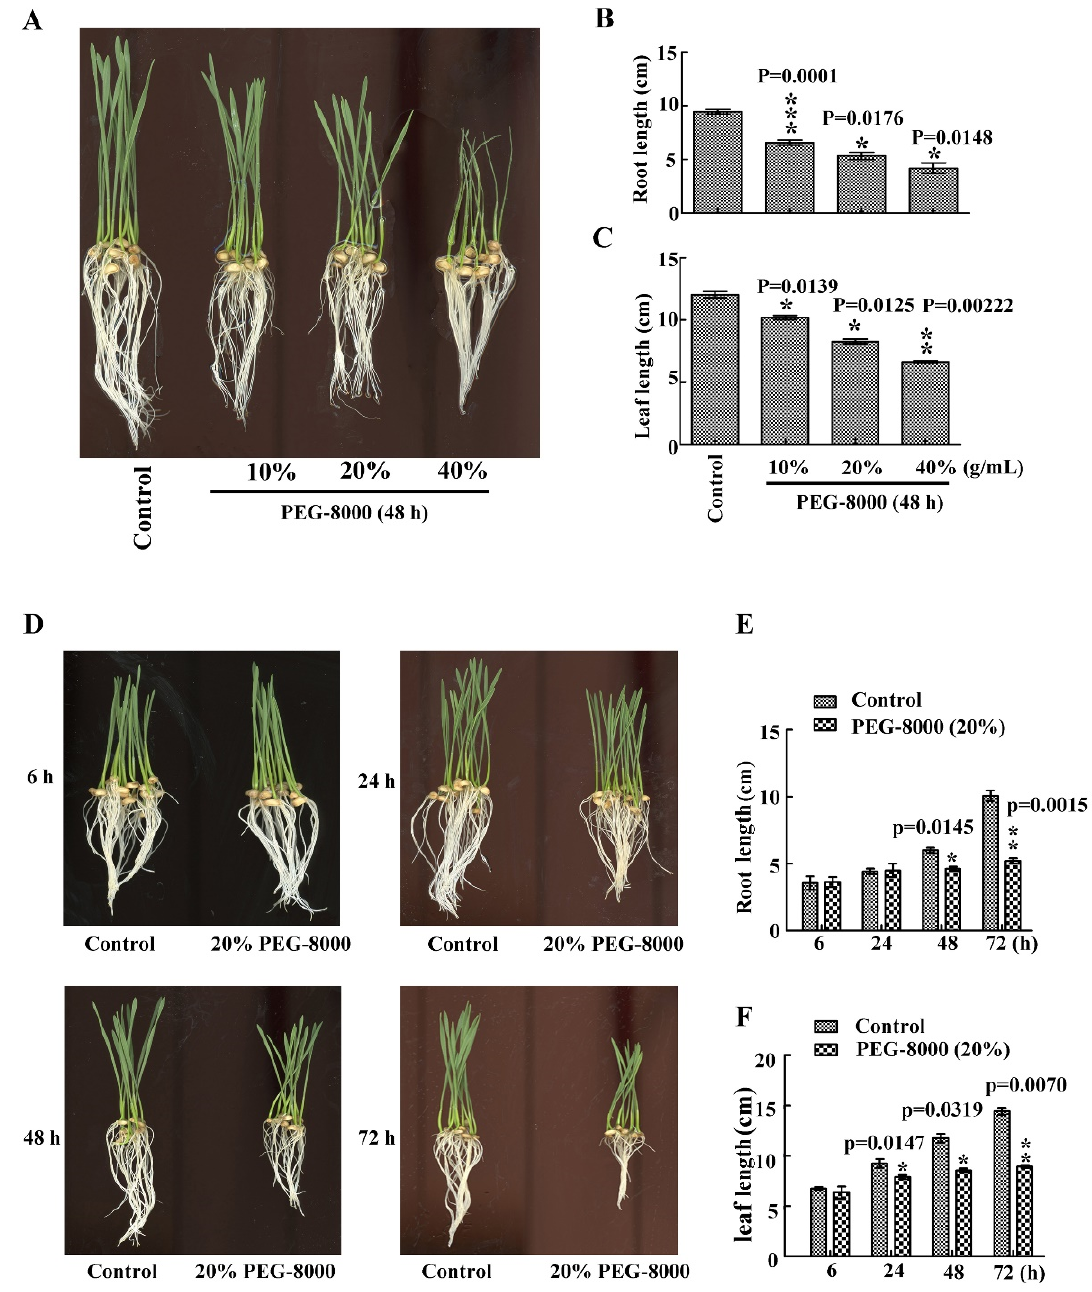
Figure 1. Effect of drought stress on seedling growth of wheat cultivar Jimai 22. Seedling phenotypes ( A ), root length ( B ) and leaf length ( C ) following treatment with 10%, 20%, and 40% PEG-8000 for 48 h. Seedling phenotypes ( D ), root length ( E ), and leaf length ( F ) following treatment with 20% PEG-8000 for 6, 24, 48, and 72 h. Control: treatment with water Bars represent the mean ± SD of three independent experiments. *, **, and *** indicate significant differences at p < 0.05, p < 0.01, and p < 0.001, respectively, according to Student’s t -test.